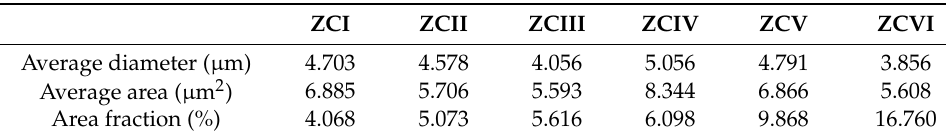
Table 5. Measurement results of recrystallized grains.